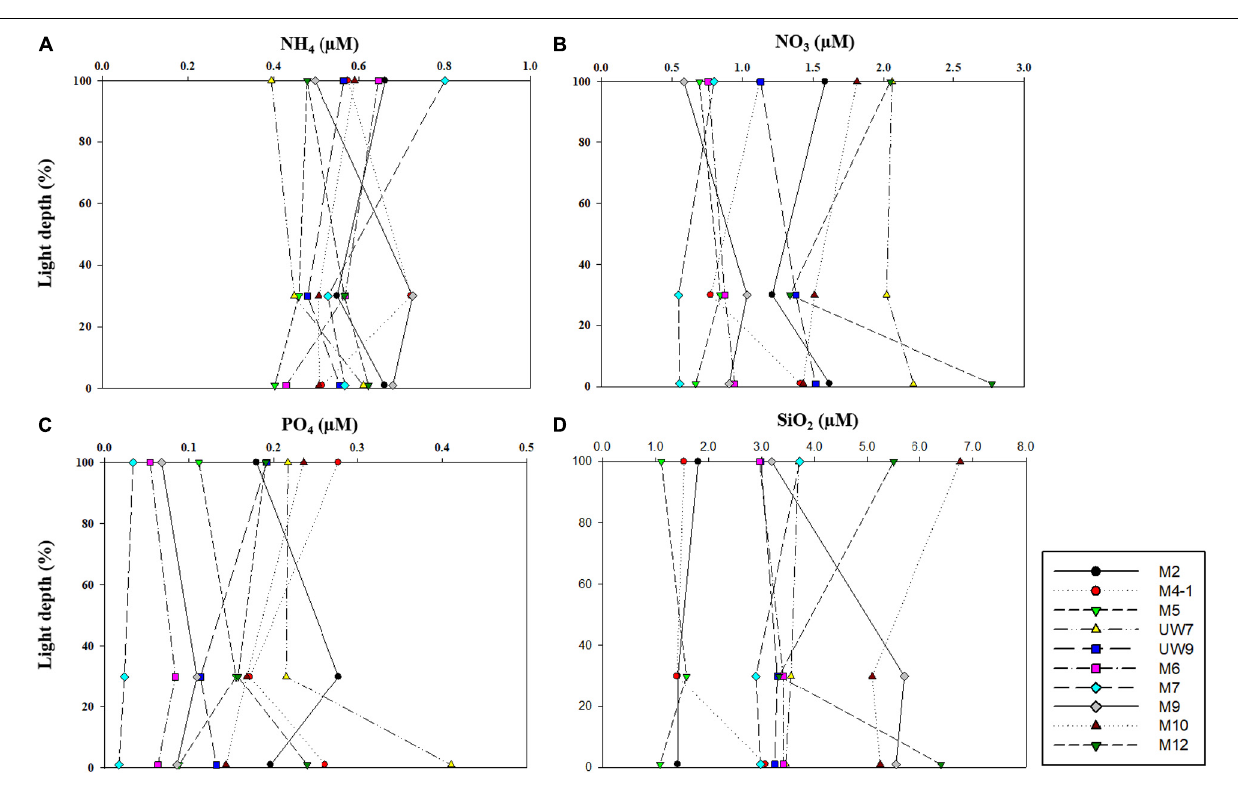
Table 1 ). In contrast, the average chl a concentrations of the small and large phytoplankton over the same depth in the